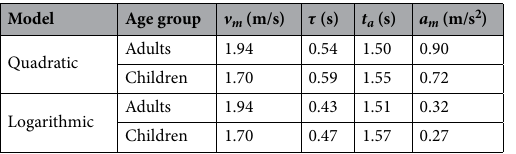
Table 1. Fitting parameters v m , t a , and τ for the group-averaged data, together with Lagrangian constant a m , in each